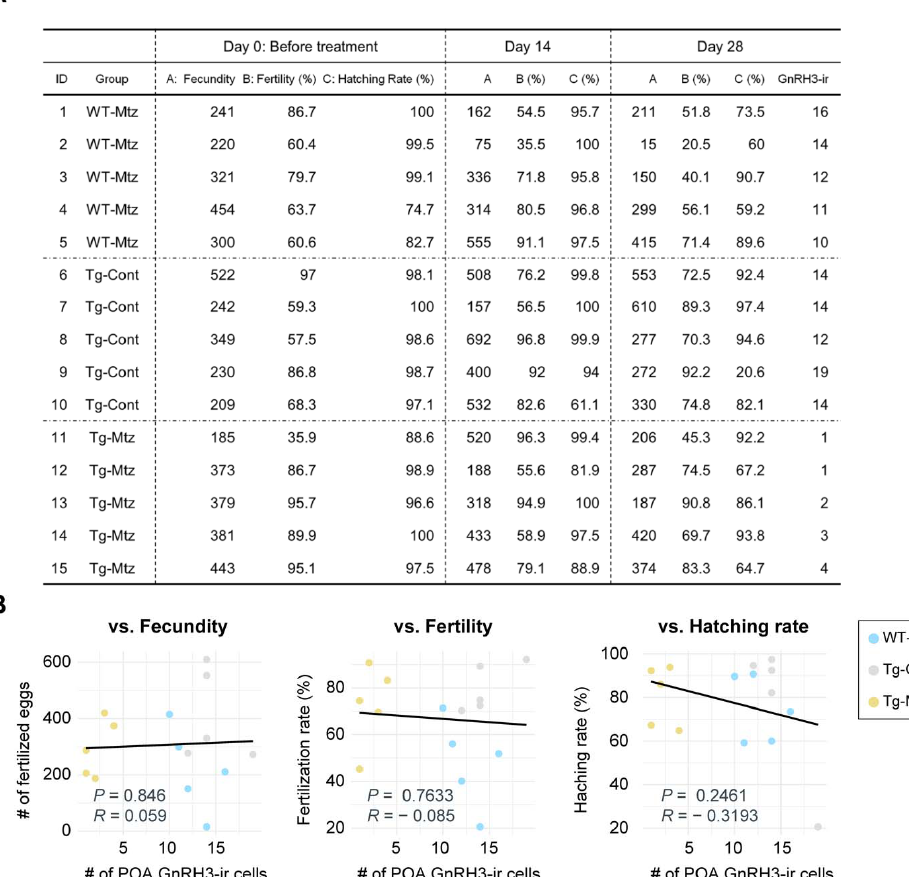
Figure 4. No correlation is observed between the number of detectable POA GnRH3 neurons and each reproductive parameter at 28 days of treatment. ( A ) Table depicting the number of remaining detectable GnRH3 immunoreactive (ir) neurons in the preoptic area, and the results of reproductive performance test for individual females from 0 days (before treatment) to 28 days of treatment. ( B ) Pearson’s correlation coefficient analysis between the number of POA GnRH3 ‐ ir cells and each reproductive parameter at 28 days of treatment. R , correlation coefficient. P , p ‐ value. Data from A. WT ‐ Mtz, WT siblings treated with 2 mM metronidazole (Mtz); Tg ‐ Cont, Tg(gnrh3:Gal4ff; UAS:nfsb ‐ mCherry) treated with vehicle; Tg ‐ Mtz, Tg(gnrh3:Gal4ff; UAS:nfsb ‐ mCherry) treated with 2 mM Mtz.